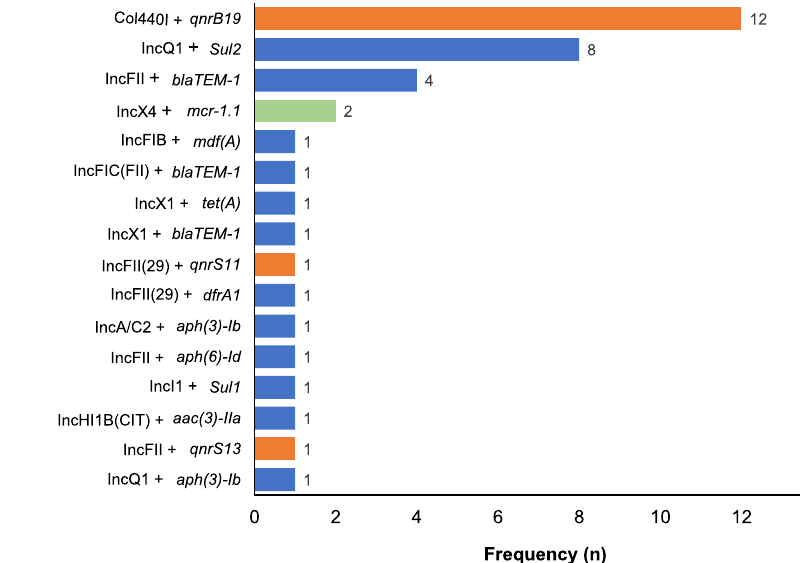
Fig. 5 Antimicrobial resistance genes carried on plasmid replicon detected in 70 PMQR Escherichia coli isolates from humans, chickens, and poultry farm/market environments. Each bar represents the resistance genes carried on the plasmid replicon. The orange bars represent PMQR genes ( qnrB or qnrS ) carried on specific plasmids. The green bar represents the PMCR gene ( mcr-1.1 ) carried on specific plasmids. The blue bars represent other AMR genes carried on